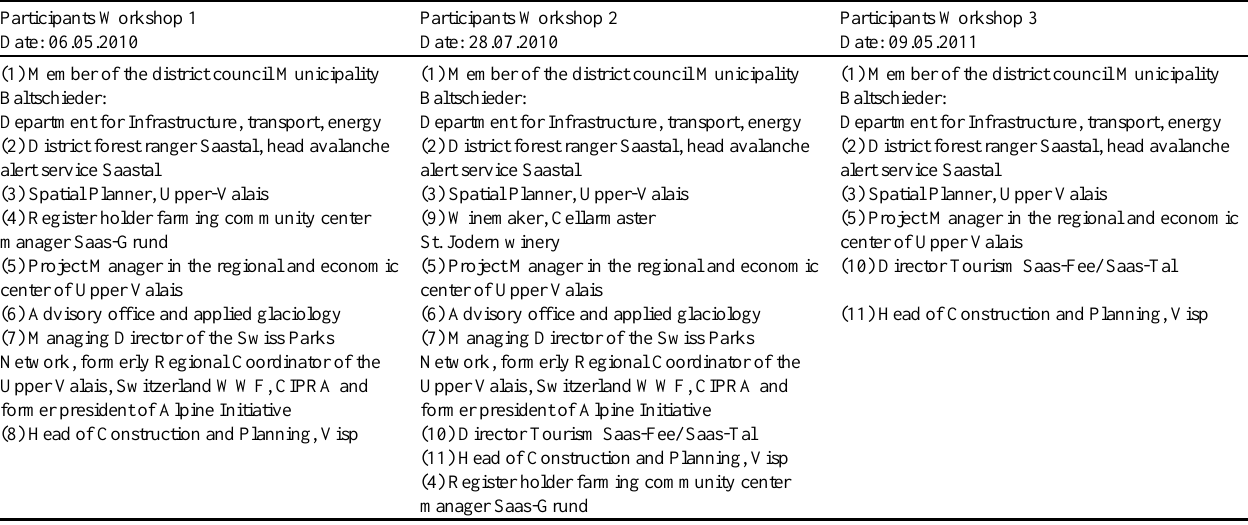
Table 1 . Participating stakeholders in Workshops 1 to